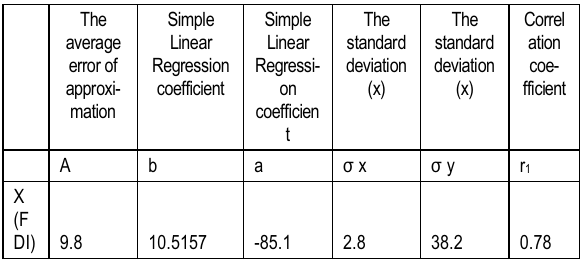
Table 3. Final estimates in terms of (cid:623)